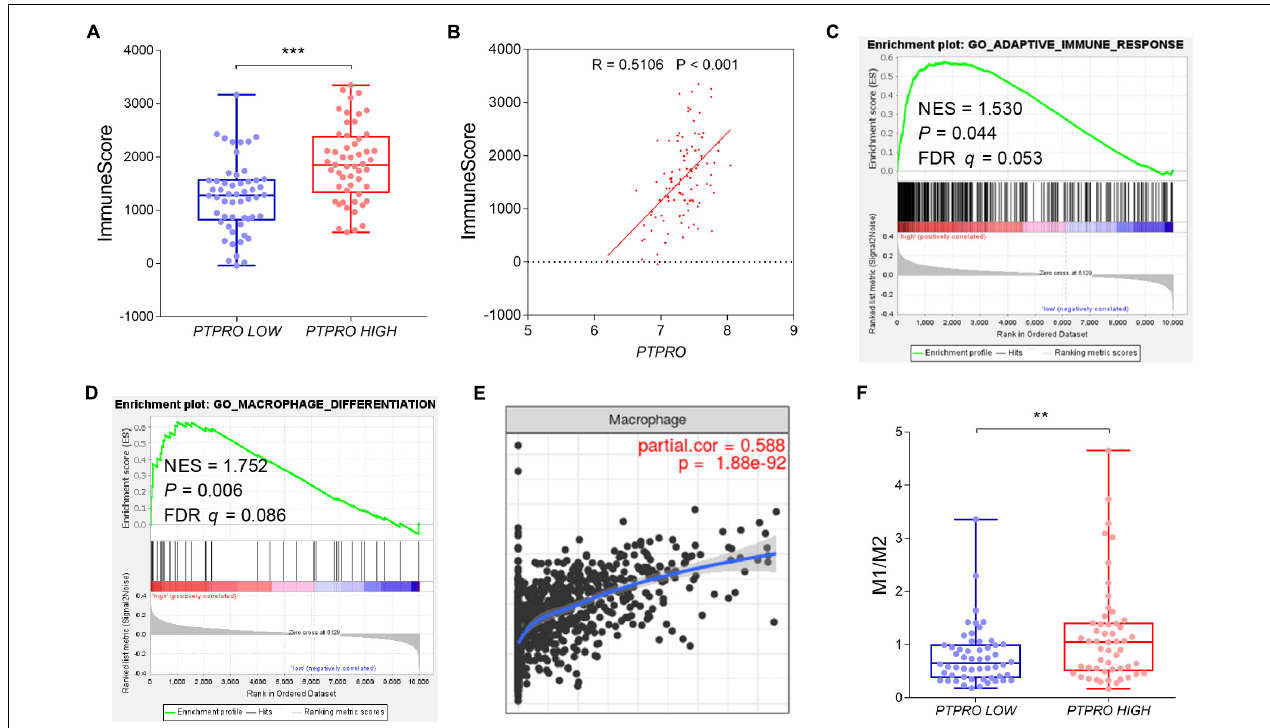
FIGURE 1 | PTPRO expression was associated with TAM infiltration in breast cancer. (A) Box and scatter plots showing the immune scores of PTPRO high expression group and PTPRO low expression group in the GEO dataset GSE36774. (B) Correlation between PTPRO expression and immune scores in the GEO dataset GSE36774. (C) GSEA showing the positive correlation between PTPRO expression and adaptive immune response signature in the GEO dataset GSE36774. (D) GSEA showing the positive correlation between PTPRO expression and macrophage differentiation-related gene signature in the GEO dataset GSE36774. (E) The correlation between PTPRO expression and the infiltration level of macrophages was presented by Tumor Immune Estimation Resource (TIMER; cistrome.shinyapps.io/timer). (F) Box and scatter plots showing M1/M2 ratio difference between PTPRO high expression group and PTPRO low expression group according to GEO dataset GSE36774. FDR q , false-discovery rate q -value; NES, normalized enrichment score; ** P < 0.01, *** P < 0.001 by Student’s t -test.